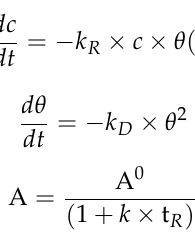
Figure S3: The Horwath-Kawazoe pore distribution, Figure S4: The TCD-NH 3 curves, Figure S5: The TGA curves of spend samples, Figure S6: The DSC curves of spend samples, Figure S7: Activity vs. t R (A) and ln(activity) vs. t R (B) curves for H-BEA, Figure S8: Activity vs. t R (A) and ln(activity) vs. t R (B) curves for H-MFI, Figure S9: The calculated X vs. experimental X for H-BEA, Figure S9: The calculated X vs. experimental X for H-MFI, Table S1: XRF results, Table S2: Activity of regenerated